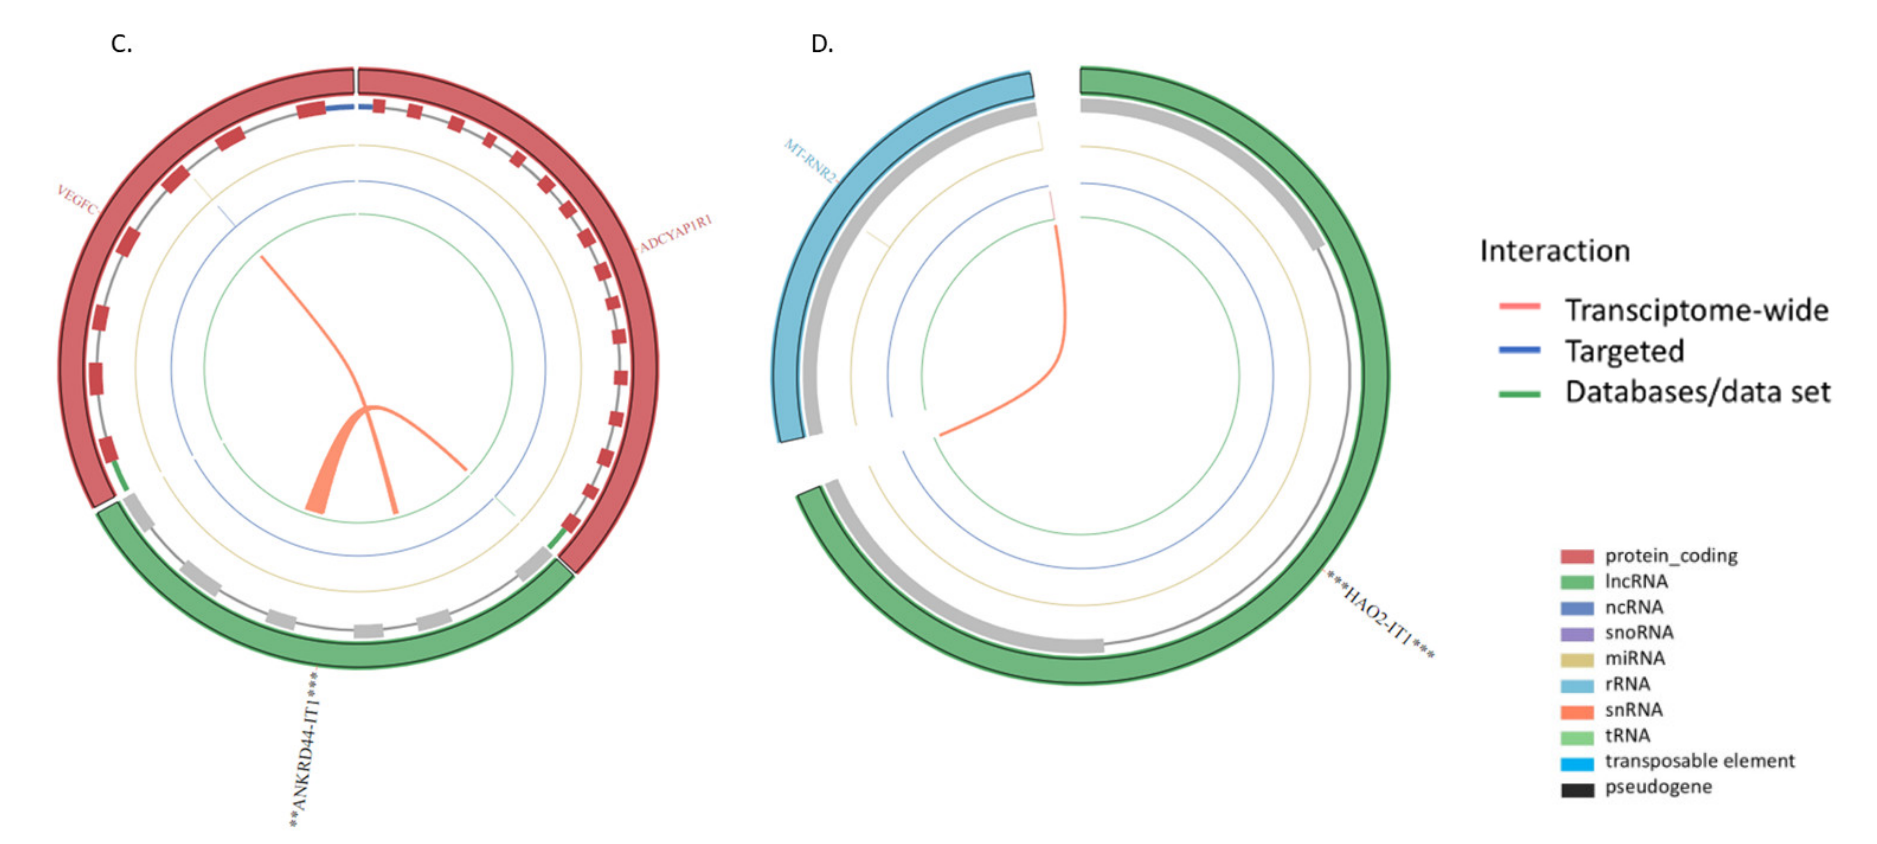
Figure 3. The circos plots show the lncRNA-RNA interaction of ( A ) SND1-IT1, ( B ) FGF14-IT1, ( C ) ANKRD44-IT1, and ( D ) HAO2-IT1. The ribbon colours highlight the interaction of the intronic transcripts with other transcripts and genes such as Transcriptome-wide (orange), Targeted (blue) and Databases/data set (green). Transcript colours; protein-coding (red), lncRNA (green), and ncRNA (blue).